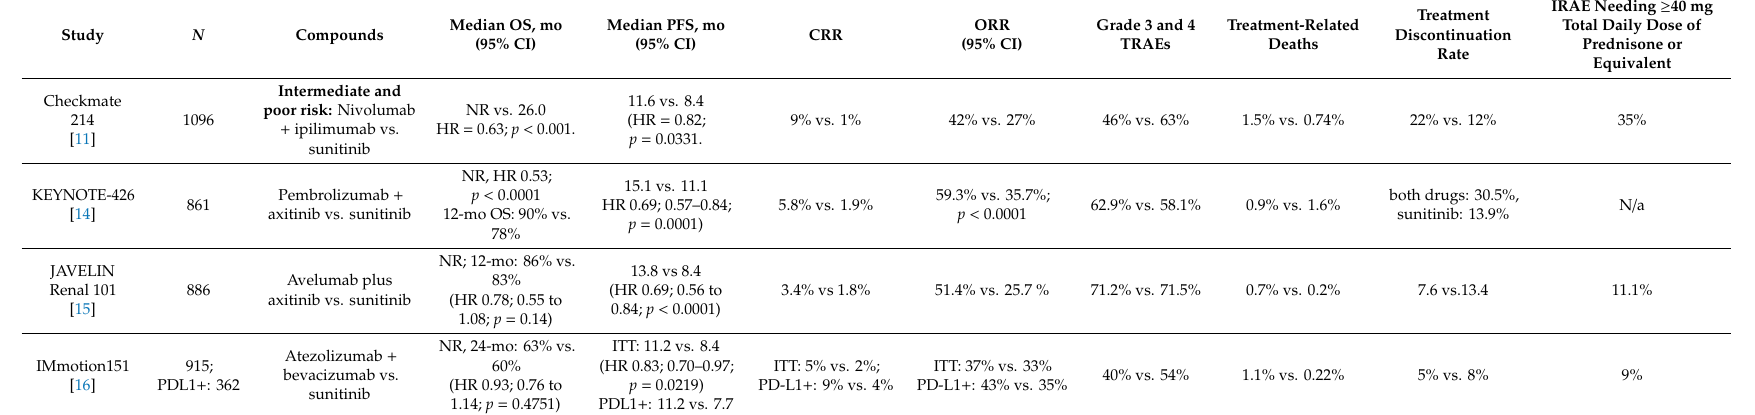
Table 1. Immunotherapy based combination trials in treatment-naive mRCC with